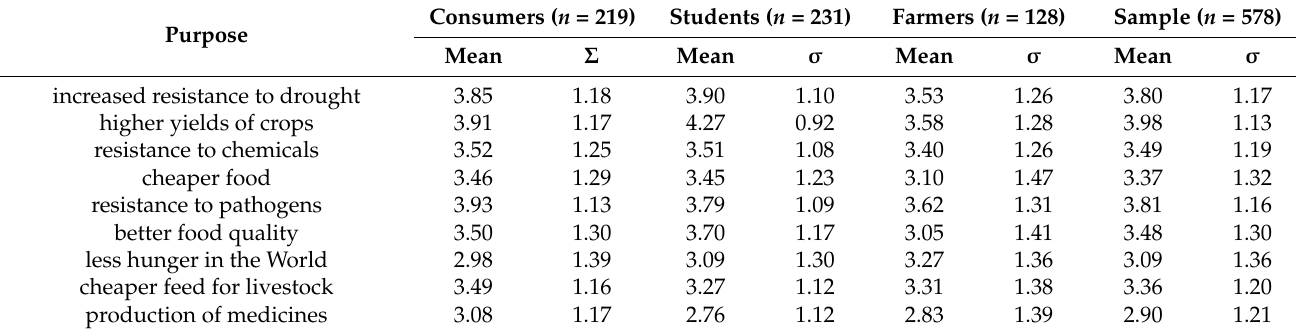
Table 2. To what extent does the introduction of GMO serve the following purposes (within the scale 1 = not beneficial at all, to 5 = highly beneficial).